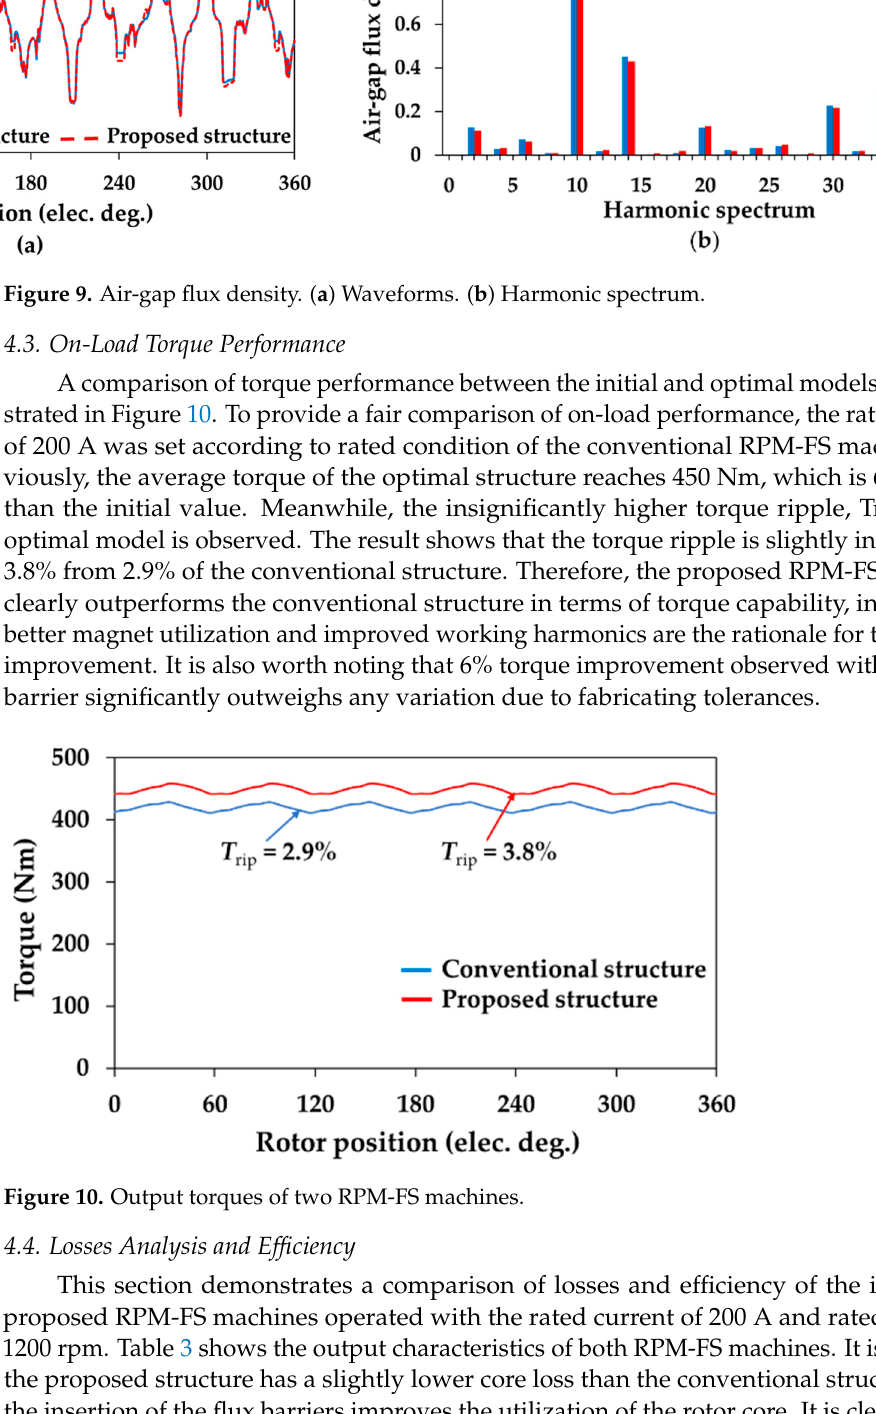
Figure 8. Magnetic flux distribution of ( a ) the conventional structure and ( b ) the optimal structure of RPM-FS machines.